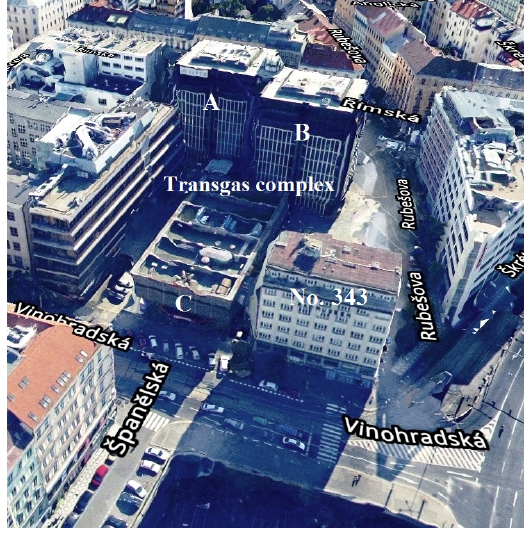
Figure 3. A view of the Transgas complex ( www. google.com – modified).